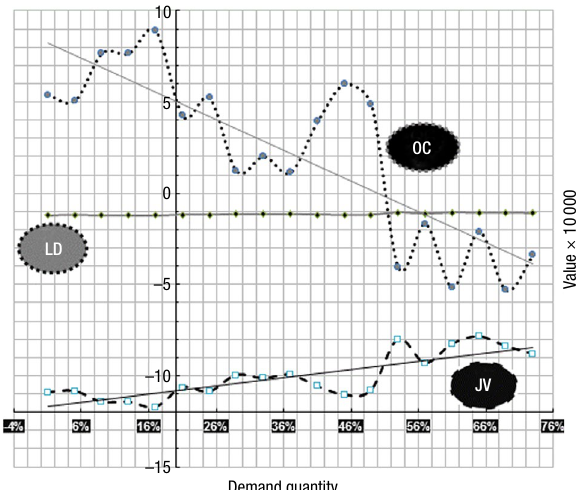
Fig. 2. Simulation of different options for entering in a